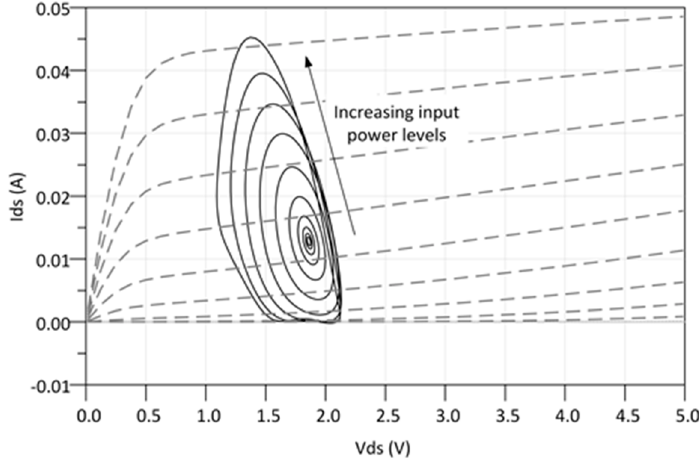
Figure 9. Dynamic load line of the transistor of the filter tuned at 1800 MHz, for di ff erent input power levels up to − 9 dBm.